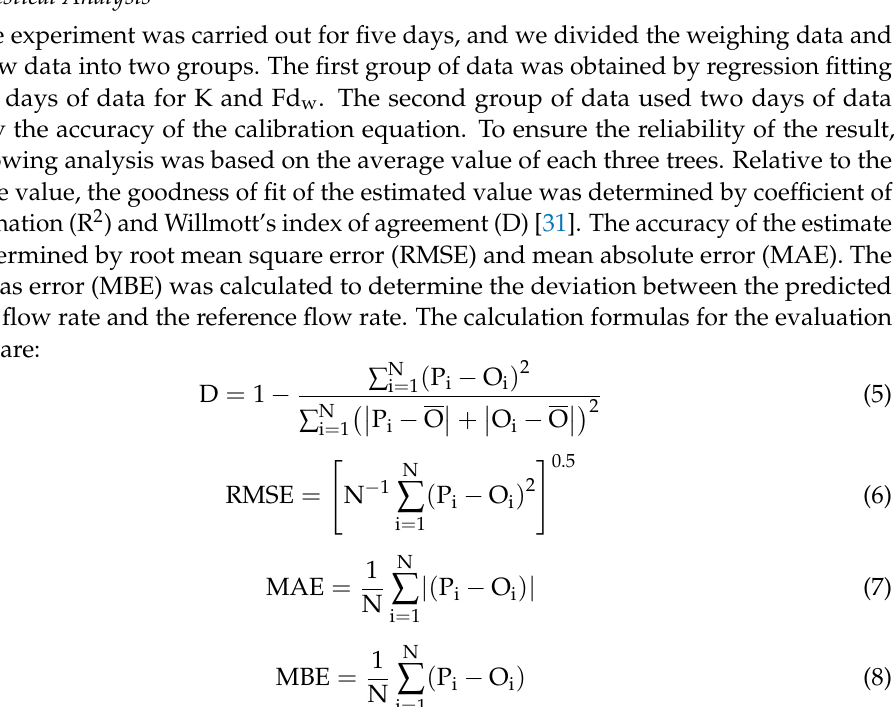
Figure 1. Schematic diagram of experimental set-up: (1) thermal dissipation probe, (2) portable forklift, (3) plastic film, (4) wide-range balance, (5) display screen.